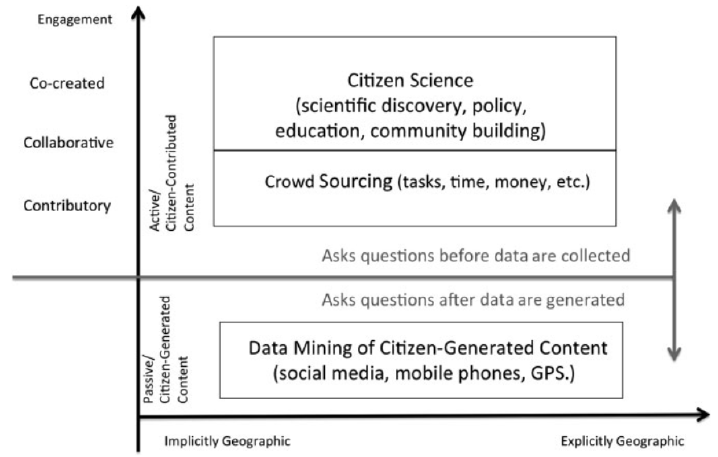
Figure 4. Schema positioning Citizen Science in the wider context of crowd-sourcing and data mining. Source: